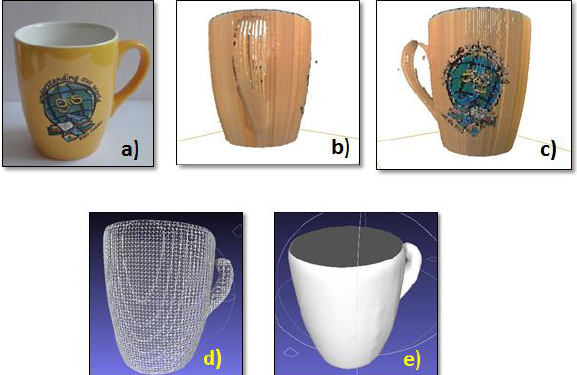
Figure 10. ceramic mug: a) photo of the object in reality; b-c) scanned cloud of points; d) processed data in form of TIN surface; e) 3D model